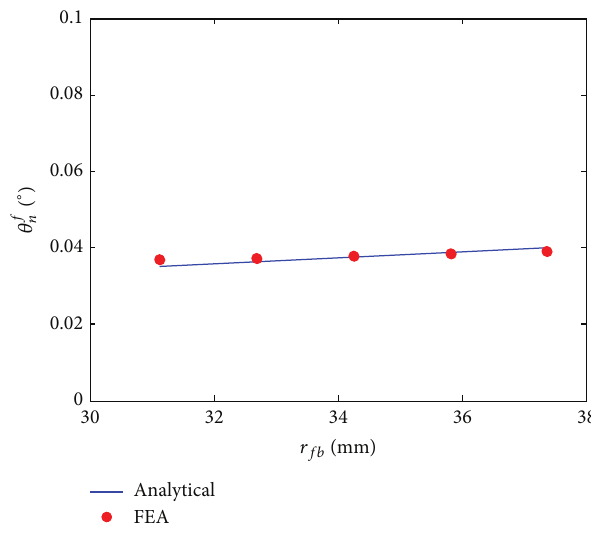
Figure 11: Rotation deformation of nut flank under different locking force with variation of 𝑟 𝑓𝑏